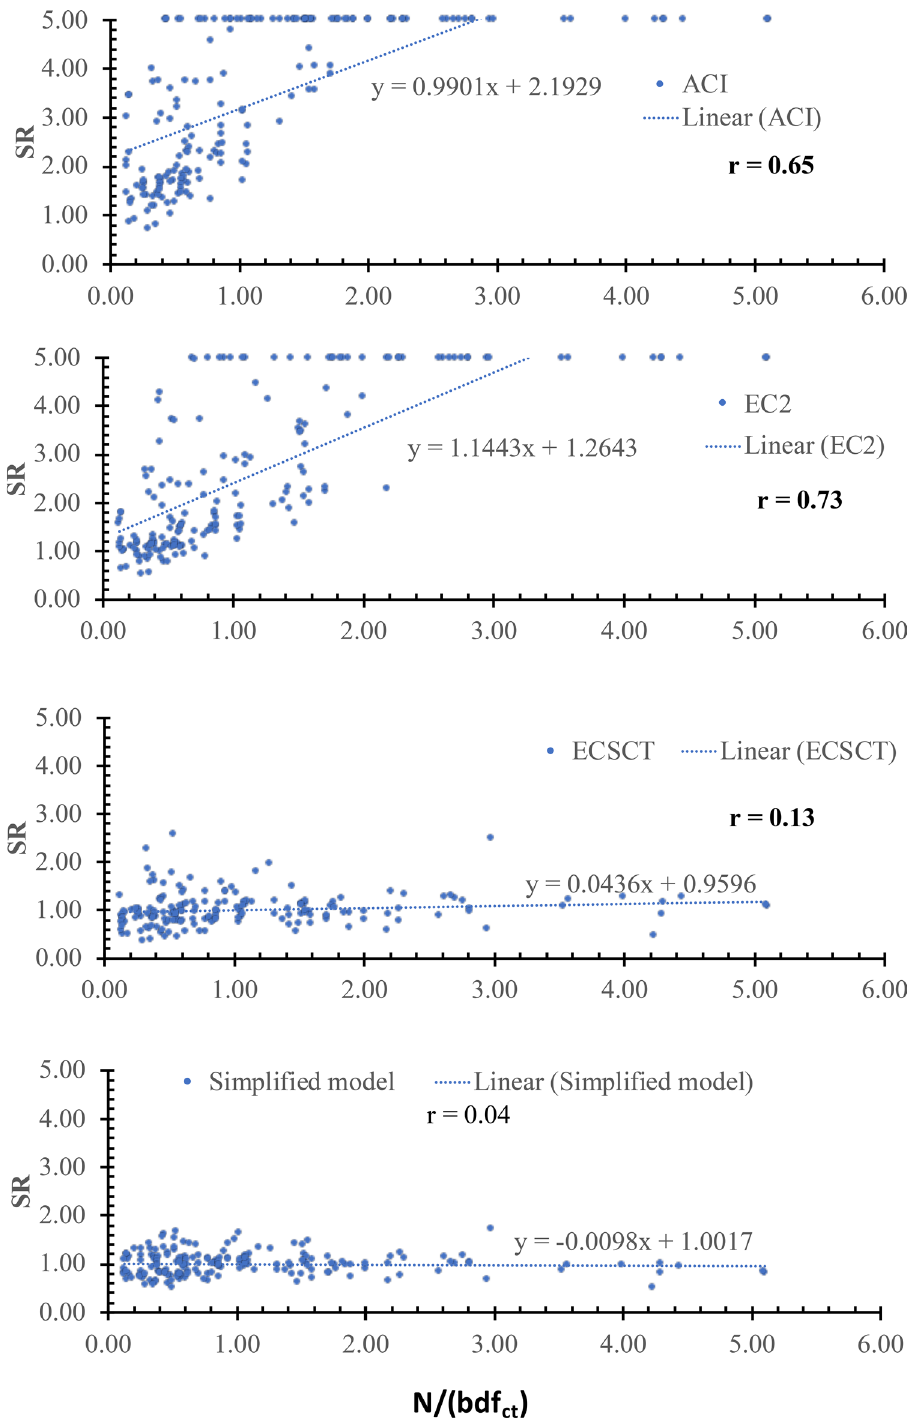
Figure 7. SR using various methods versus the N /( bdf ct